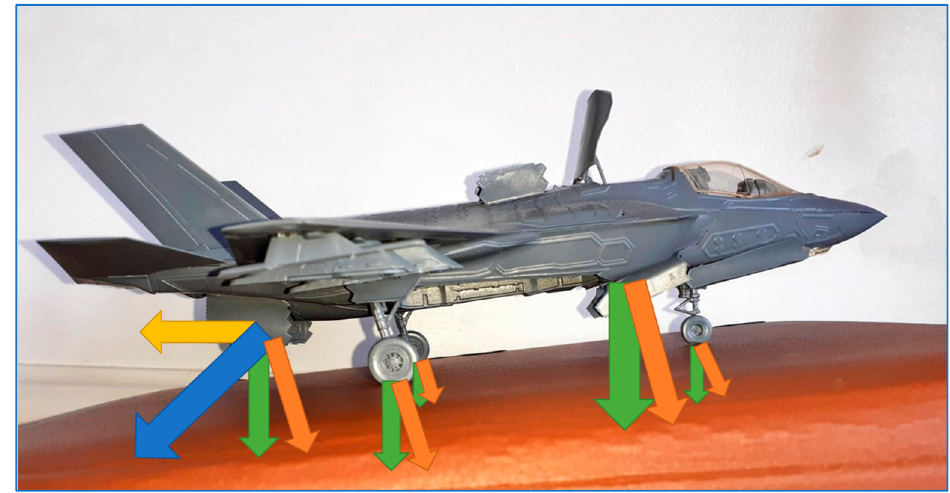
Figure 8. The directions of the dynamic forces resolved for ramp loading.